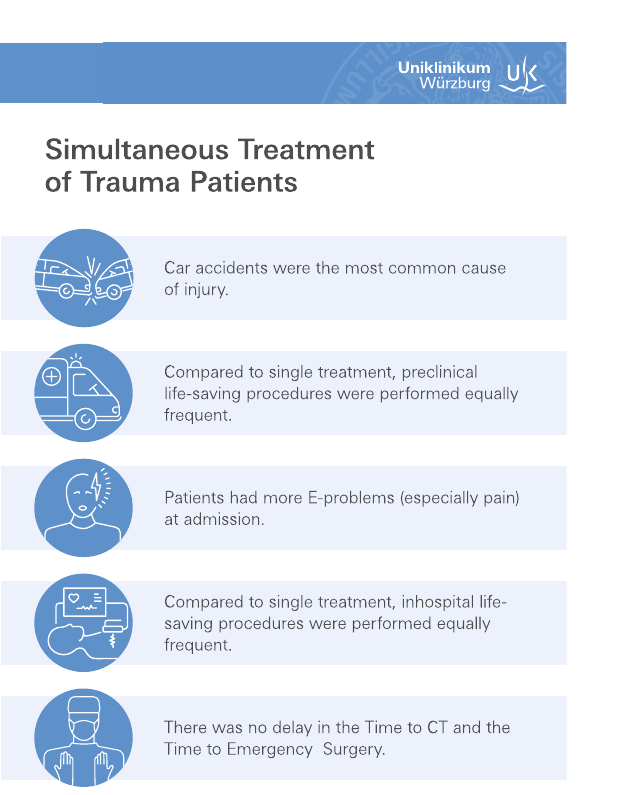
Figure 3. Main outcomes of simultaneous treatment of trauma patients in a dual-room trauma suite with integrated movable sliding gantry CT system compared to single patient